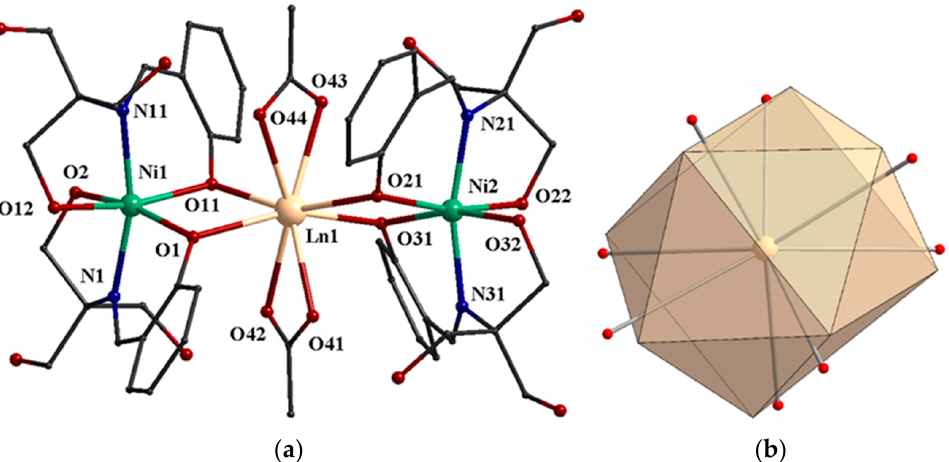
Figure 1. ( a ) Partially labeled plot of the cationic part of 1 – 3 ; hydrogen atoms are omitted for clarity. Color code: Ni II green; Ln III = Dy( 1 ), Ho( 2 ), Y( 3 ) tan; O, red; N, blue; C, grey. ( b ) The biaugmented trigonal prism around the Ln III ion.